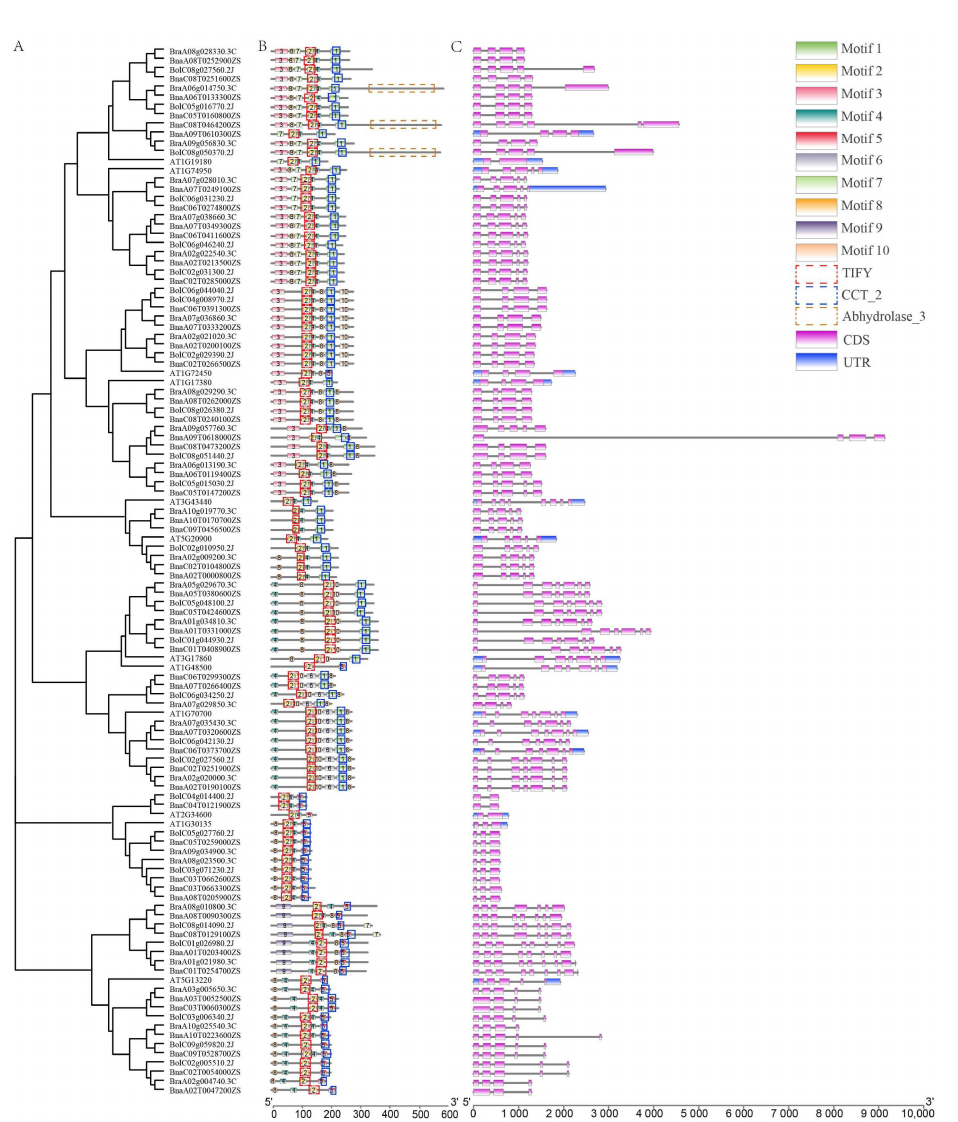
Figure 2. Phylogenetic analysis ( A ), Conserved motif ( B ) and gene structure ( C ) of 114 JAZ proteins from Arabidopsis , B. napus , B. rapa , and B. oleracea